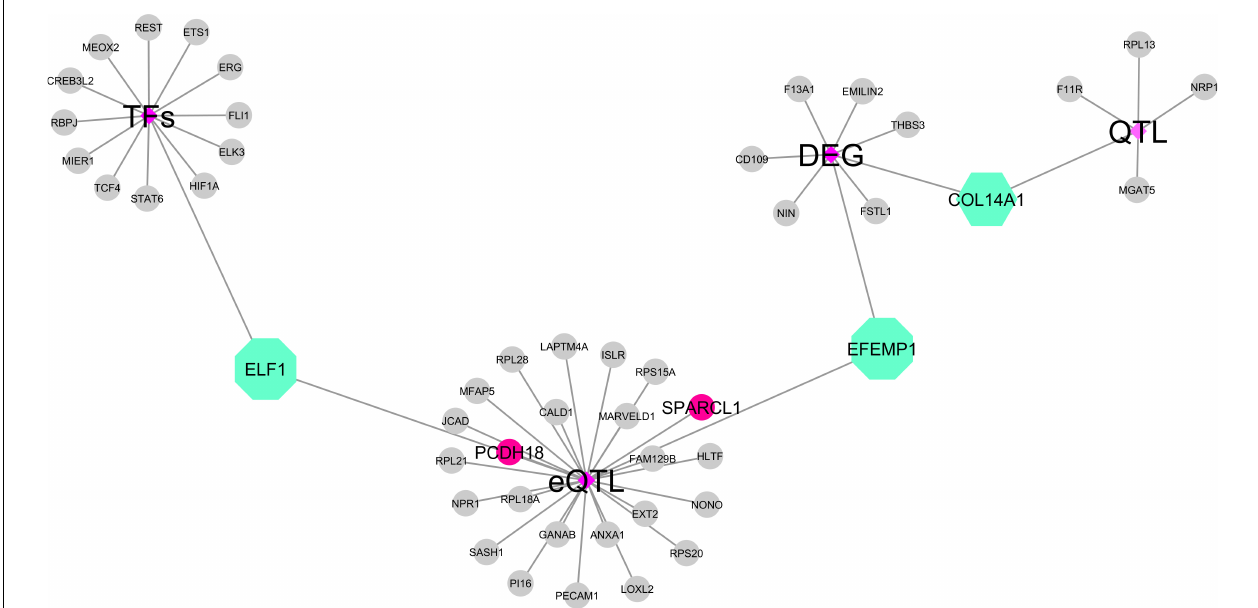
FIGURE 6 | The integrative data network of the hub genes identified in the present study with data from previous functional studies. Shown in the figure are transcription factors, annotation as transcription factors, genes affected by expression quantitative trait locus (eQTLs), and genes previously associated with feed efficiency (differentially expressed genes and QTLs). The purple diamonds represent the information from previous studies, the green octagons are the hub genes from the present study that were also identified in more than one study, the gray circles novel are hub genes from the present study, and the pink circles are the hub genes affected by